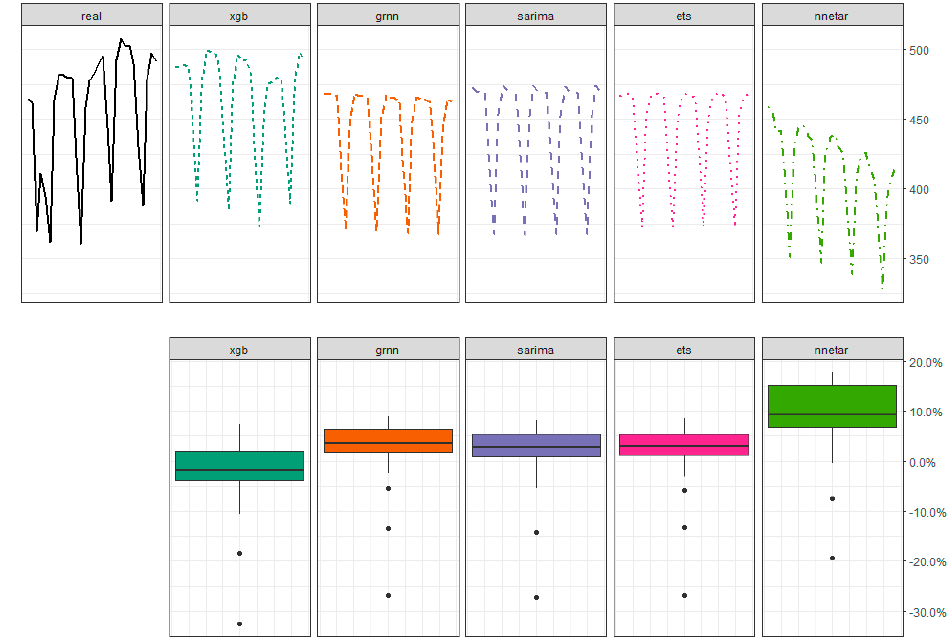
Figure 12. Monthly forecast (description as above).